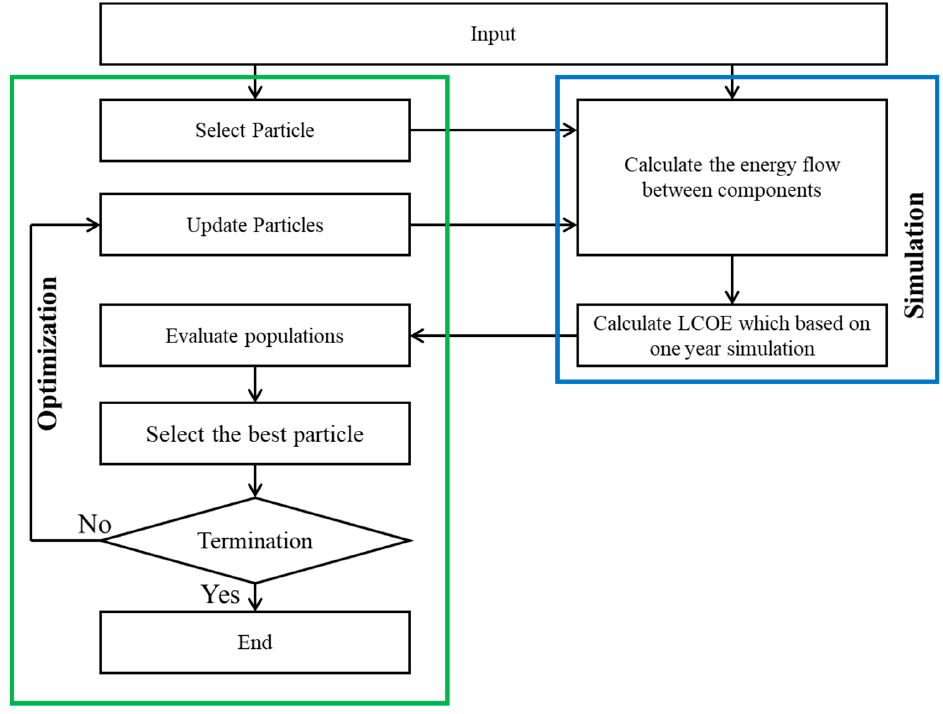
Figure 5. The connection between the optimization and simulation parts. Adopted from [40].